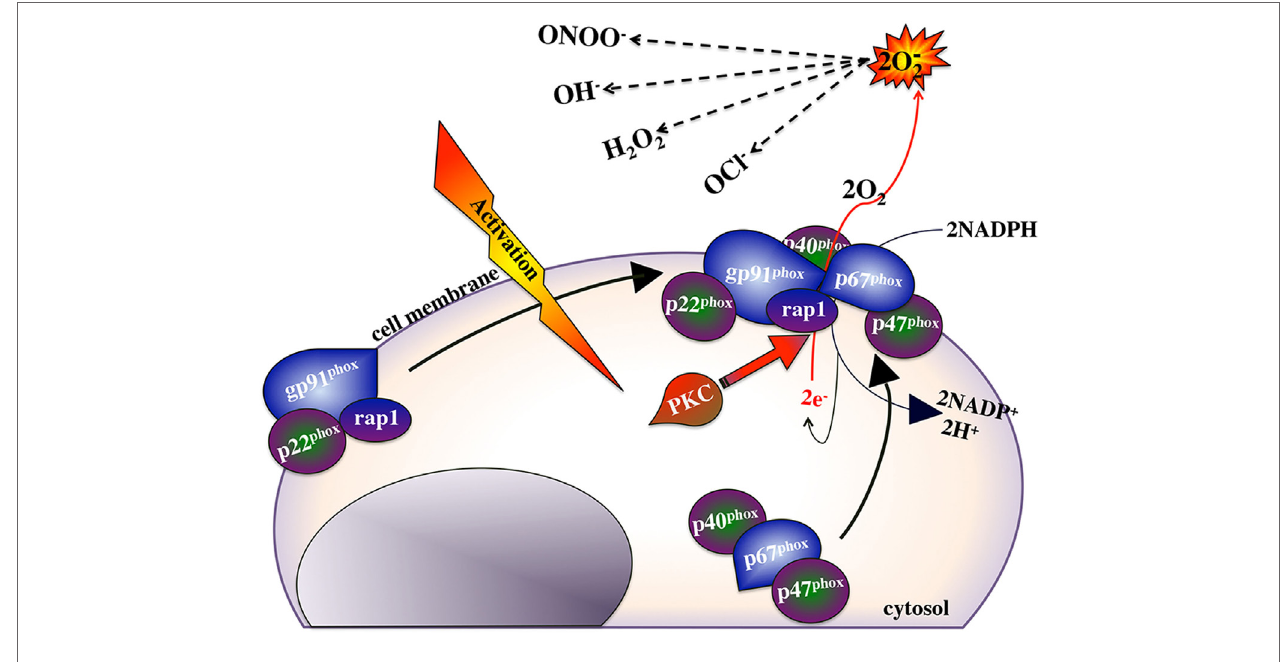
FigURe 2 | NADPH oxidase and the reactive oxygen